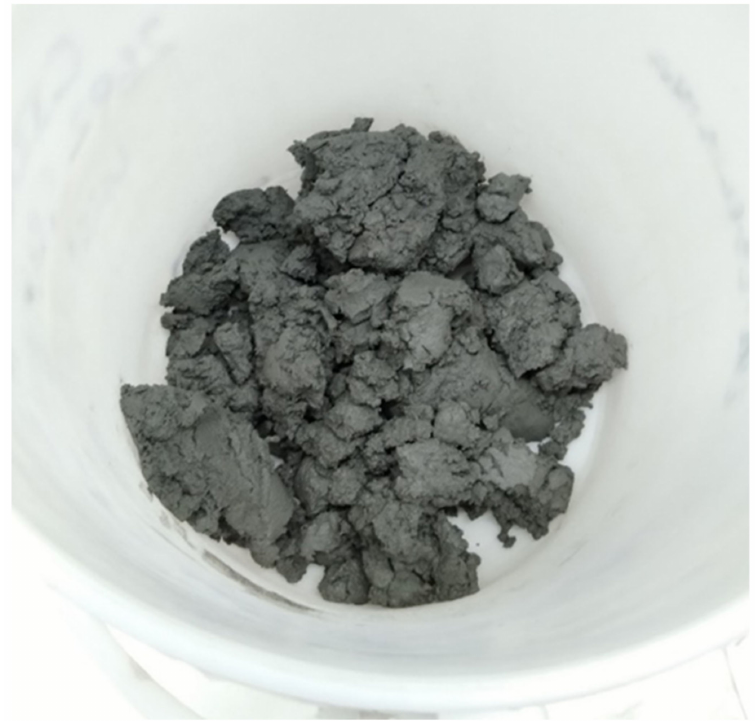
Figure 3. Tailings pulp with a Cp of 83%